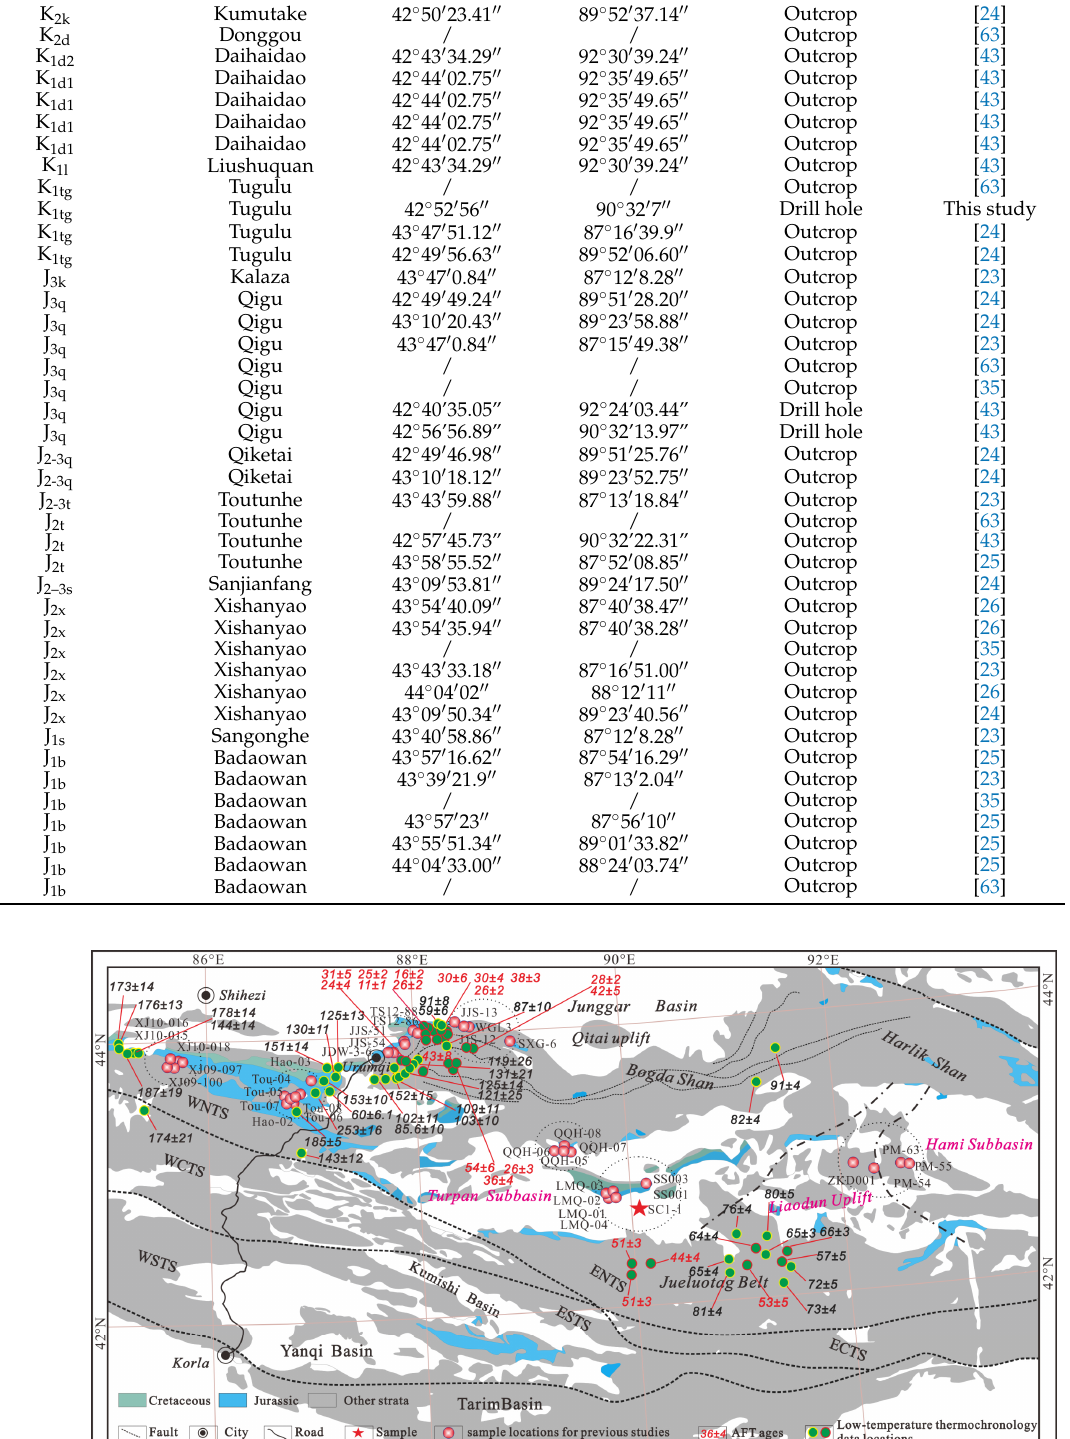
Figure 3. Geographic location of detrital-zircon samples and the apatite-fission-track age-distribution characteristics in the Turpan-Hami basin and its adjacent areas (the ages were obtained from [37,92–101] and references therein).